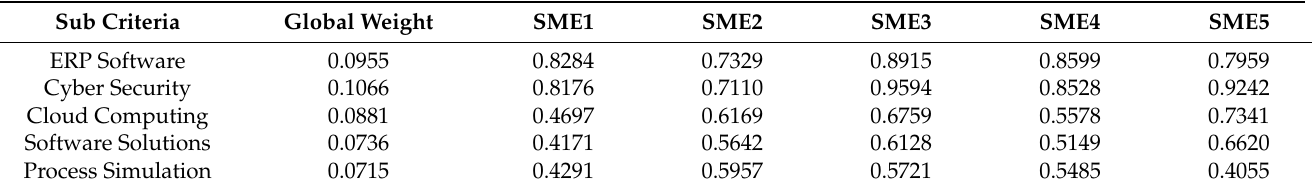
Table 9. Global weights of sub-criteria and performance measurement of